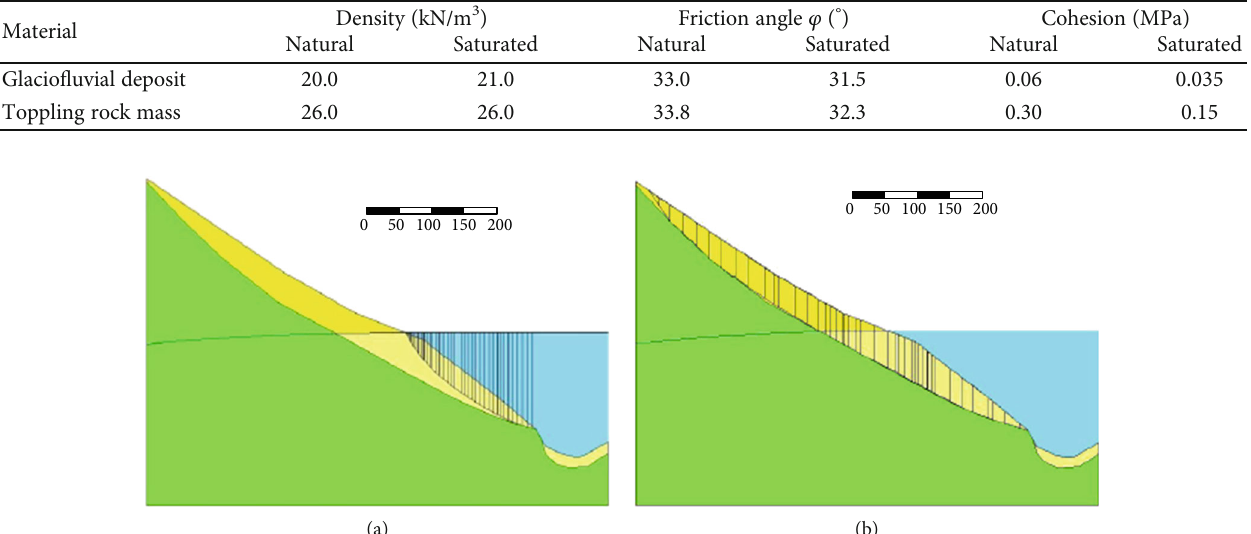
Figure 8: Two typical failure modes of the glacio fl uvial deposit: (a) Local failure; (b) Overall failure.